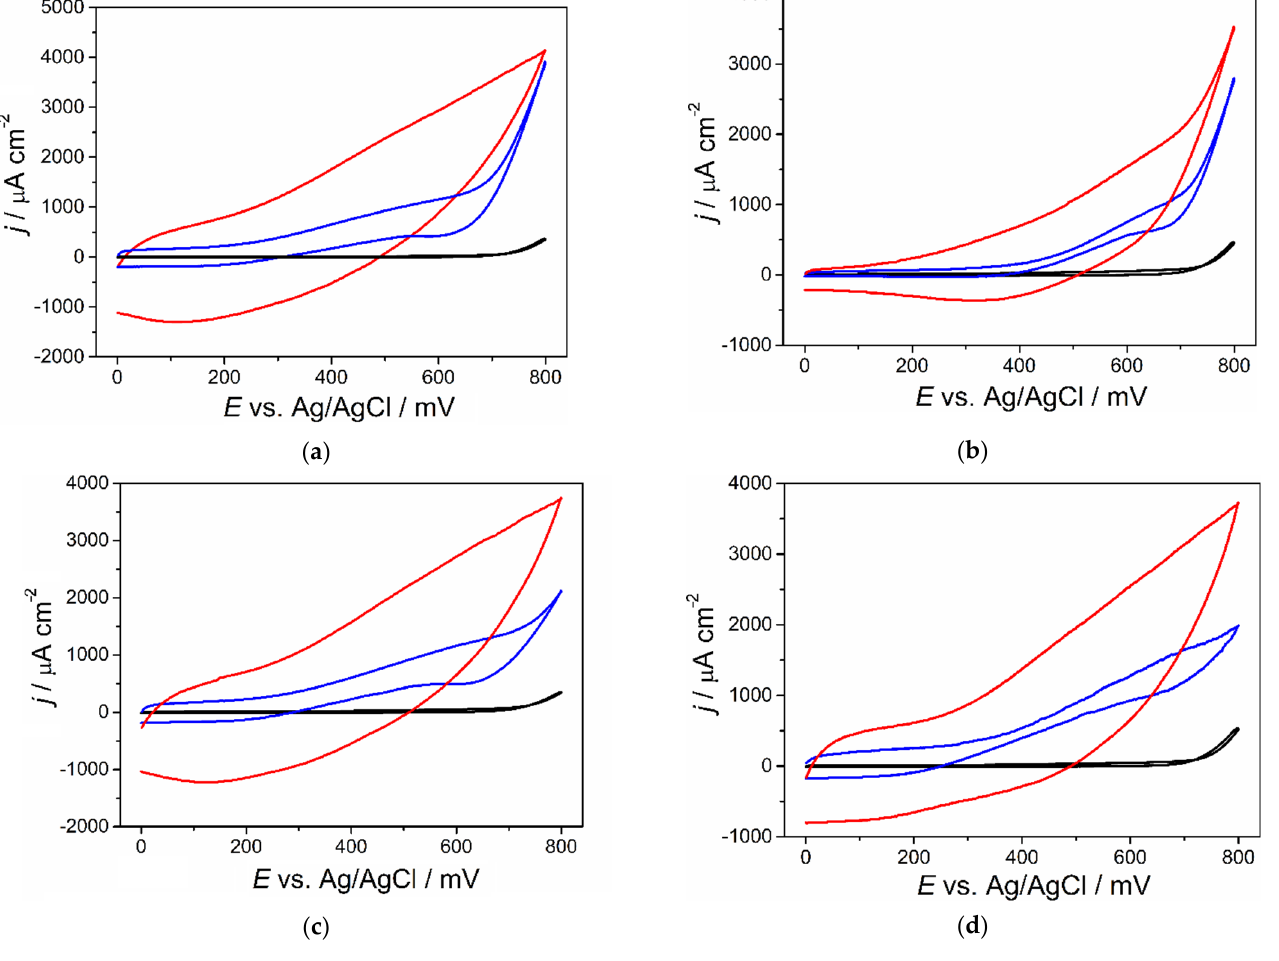
Figure 2. Cyclic voltammograms of 1 mmol L − 1 saccharides in 0.1 mol L − 1 NaOH using bare SPCE (black line), CuFE (blue line) and pCuFE (red line) and scan rate 50 mV s − 1 : ( a ) glucose; ( b ) sucrose; ( c ) fructose; ( d ) galactose. Each experiment was performed on a newly prepared sensor.